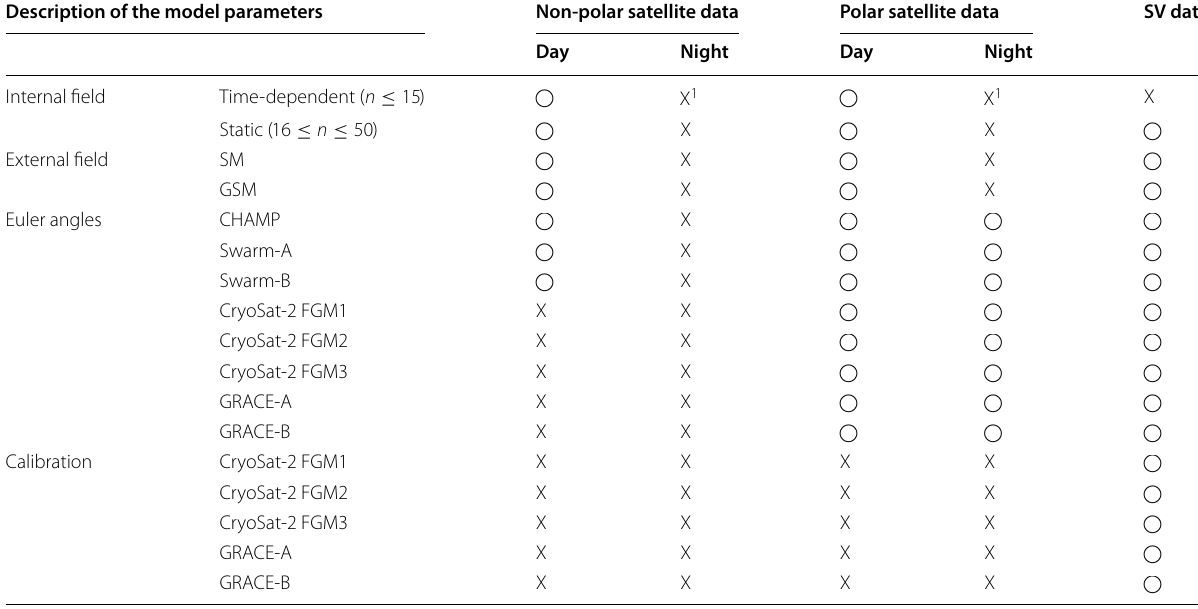
Table 2 Overview of which data subset constrained which part of the model. The cross refers to non-zero entries in the matrix of partial derivatives, whereas the circle refers to zeros. The SV data refer to the annual difference of the revised monthly means